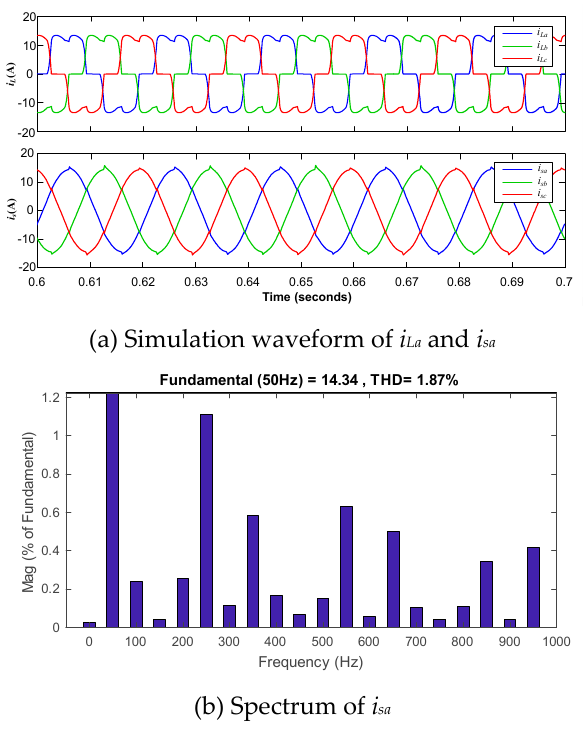
Figure 5. Simulation waveform of SAPF based on SMC in steady state.